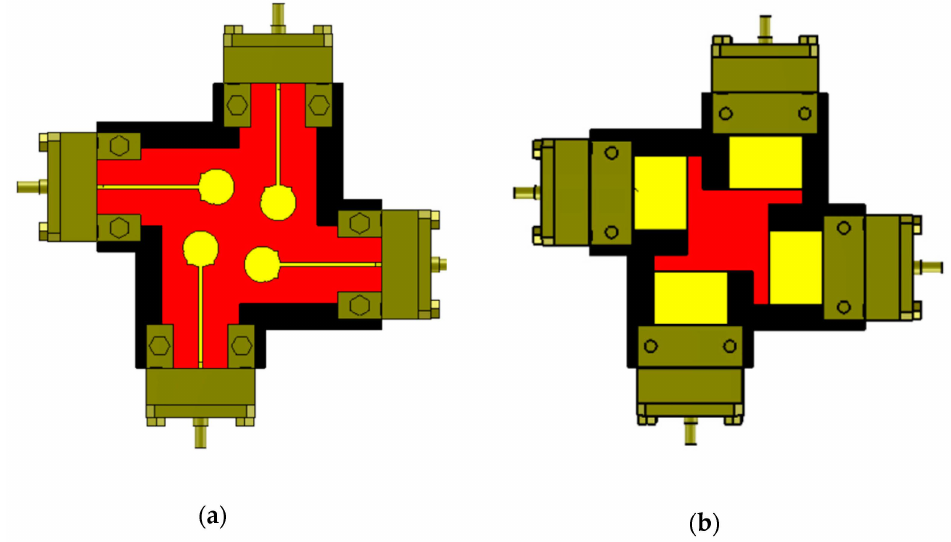
Figure 5. The prototype of 4 elements MIMO antenna with connector: ( a ) Top View ( b ) Bottom